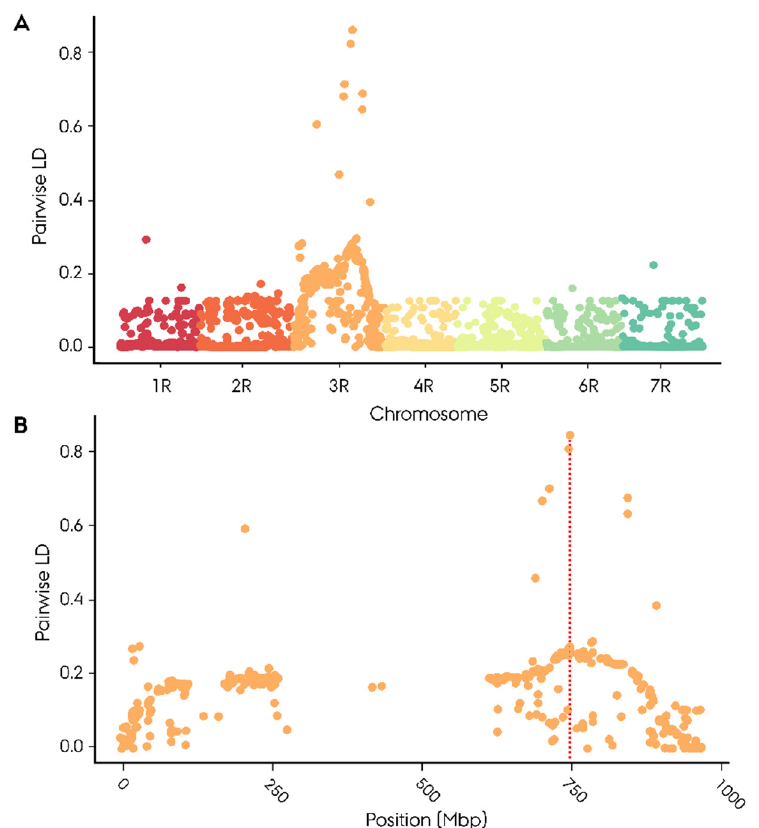
Figure 4. Mapping of an SNP marker derived from 90K wheat array highly associated with restora- tion of male fertility in 181 ( Secale cereale L.) F 2 plants by genome-wide pairwise linkage disequilibrium (LD) towards 2448 informative SNP markers with accurate mapping position on ‘Lo7’ rye reference genome. ( A ) Genome-wide distribution of LD, ( B ) LD distribution on 3R chromosome.